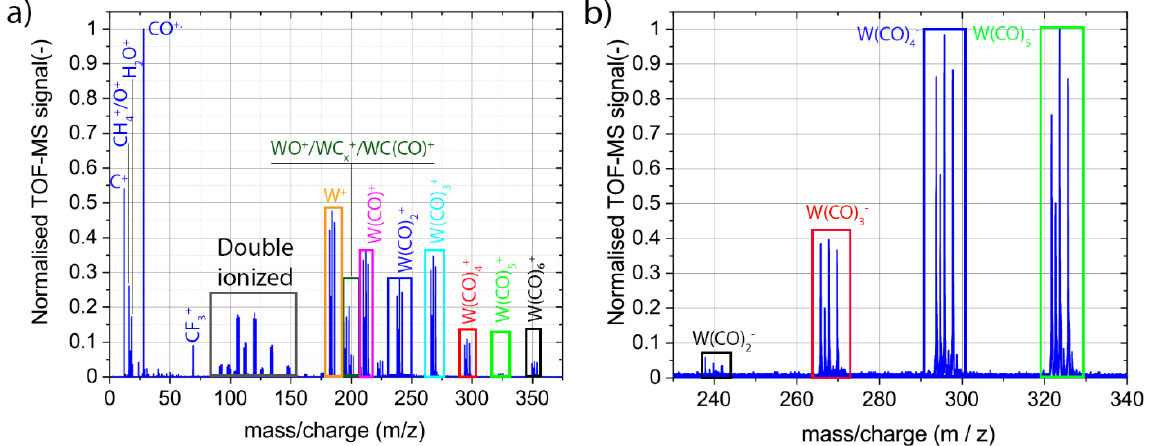
Figure 6. Mass spectra of ionized fragments registered during FEBID (10 kV, 30 nA) with W(CO) 6 accumulated over around 40 min: ( a ) cationic fragments and ( b ) anionic fragments.